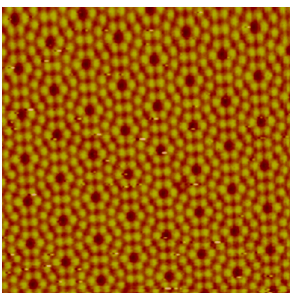
Figure 6. STM image of the Si(111)-7 × 7 reconstructed surface showing atomic scale resolution of the top-most layer of silicon atoms. Reproduced with permission from reference [22].